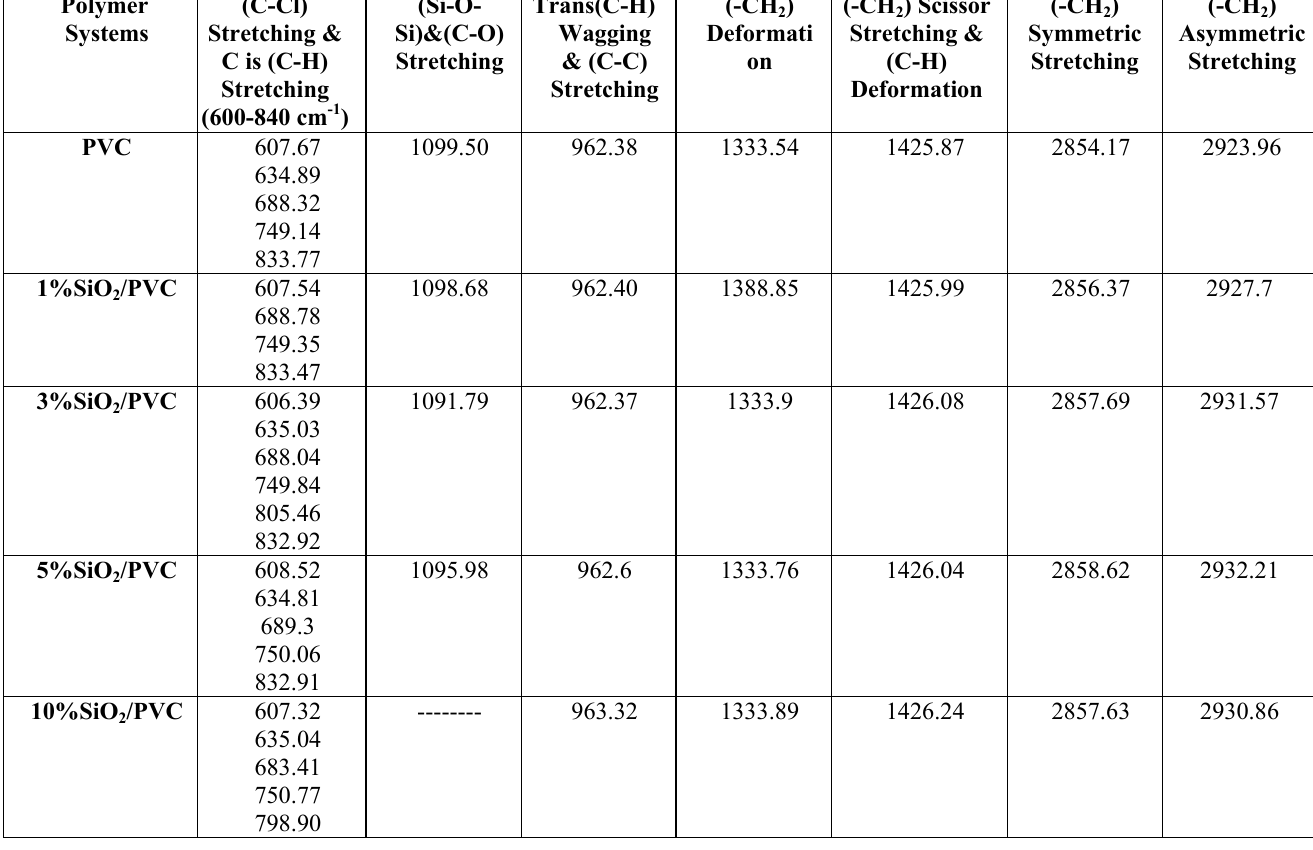
Table 6: FTIR characteristics of PVC & PVC